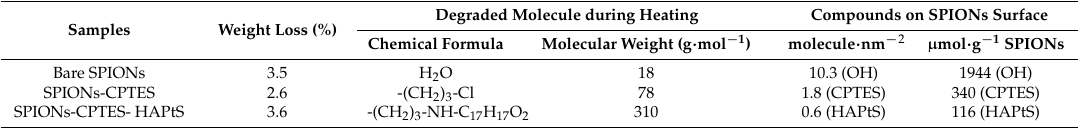
Figure 8. XPS spectra of C1s and O1s of bare SPIONs, SPIONs-CPTES, and SPIONs-CPTES-HAPtS samples. Table 5. Thermogravimetric data and calculation of the number of molecules on SPIONs’